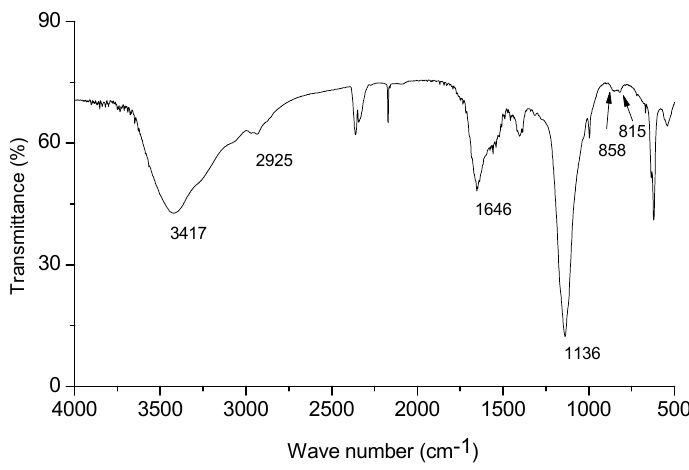
Figure 3. The infrared spectrum of the exopolysaccharide.